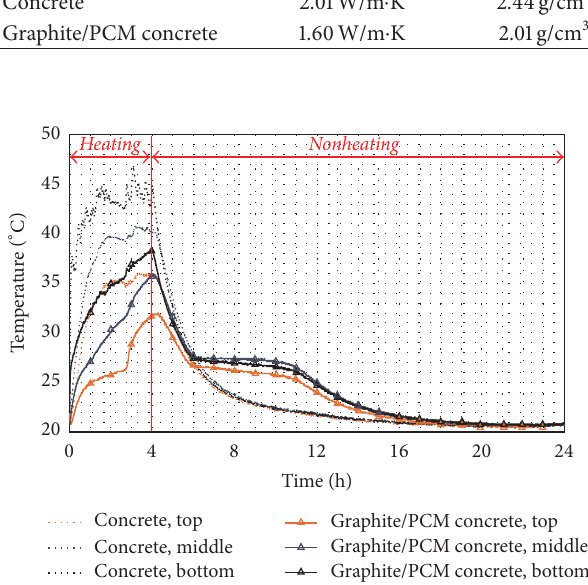
Figure 2: Experiment result of the surface and internal tempera- tures.